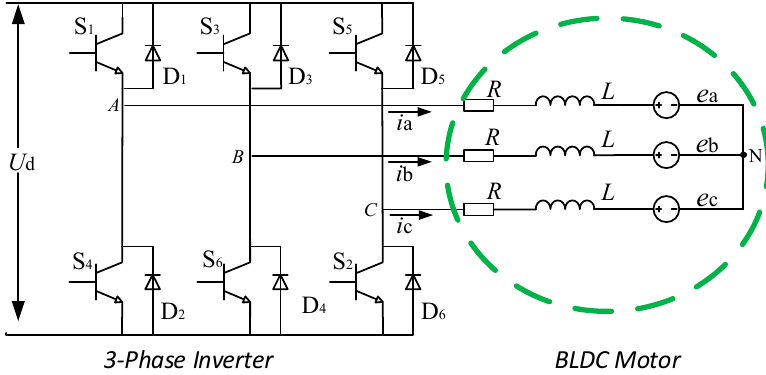
Figure 1. A brushless direct current motor (BLDCM) and a three-phase inverter block diagram.